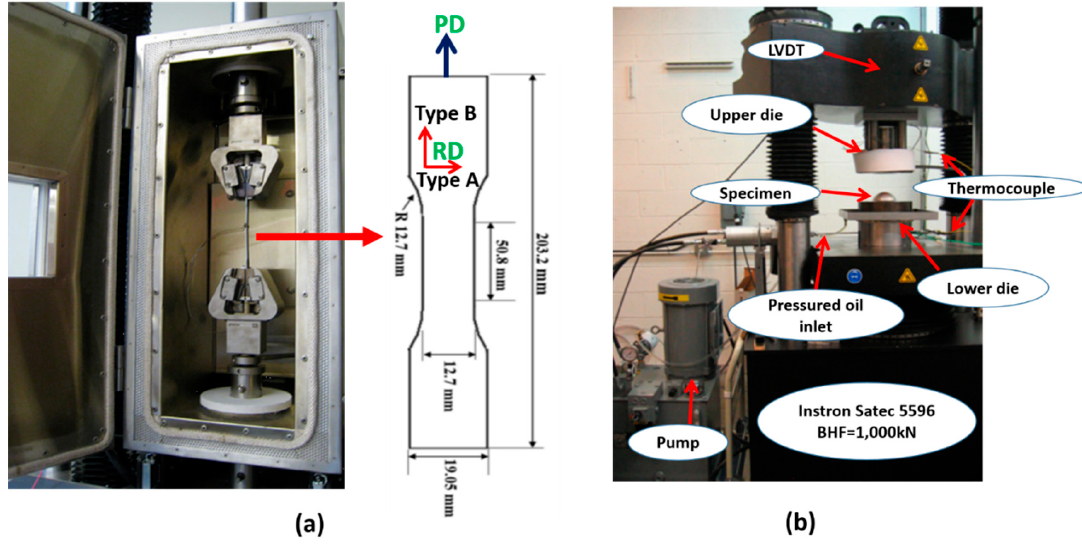
Figure 2. ( a ) Warm tensile test device and tensile test specimen dimensions and configurations, ( b ) hydraulic bulge testing device.